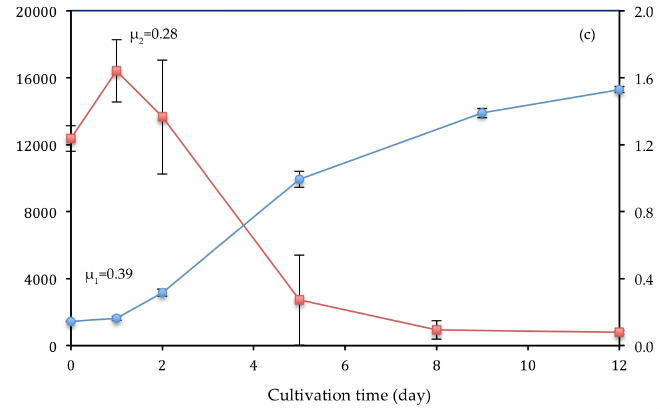
Figure 6. ( a ) Control ( b ) T1 ( c ) T2. Optical density of C. vulgaris and depletion of PO 4 -P (mg L − 1 ). Bars represent SD. Absence of a bar indicates negligible SD.